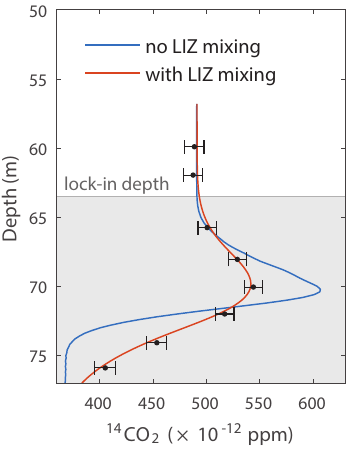
Figure 1. The 14 CO 2 bomb spike as observed and simulated in firn air at NEEM, northern Greenland (Buizert et al., 2012). Continued mixing within the lock-in zone (LIZ) is needed to correctly simulate the smoothness of the observations. Both simulations use the firn diffusivity values as presented in Buizert et al. (2012); the eddy- type LIZ diffusion was either turned on (red curve) or off (blue curve). The case without LIZ mixing was not tuned separately to the